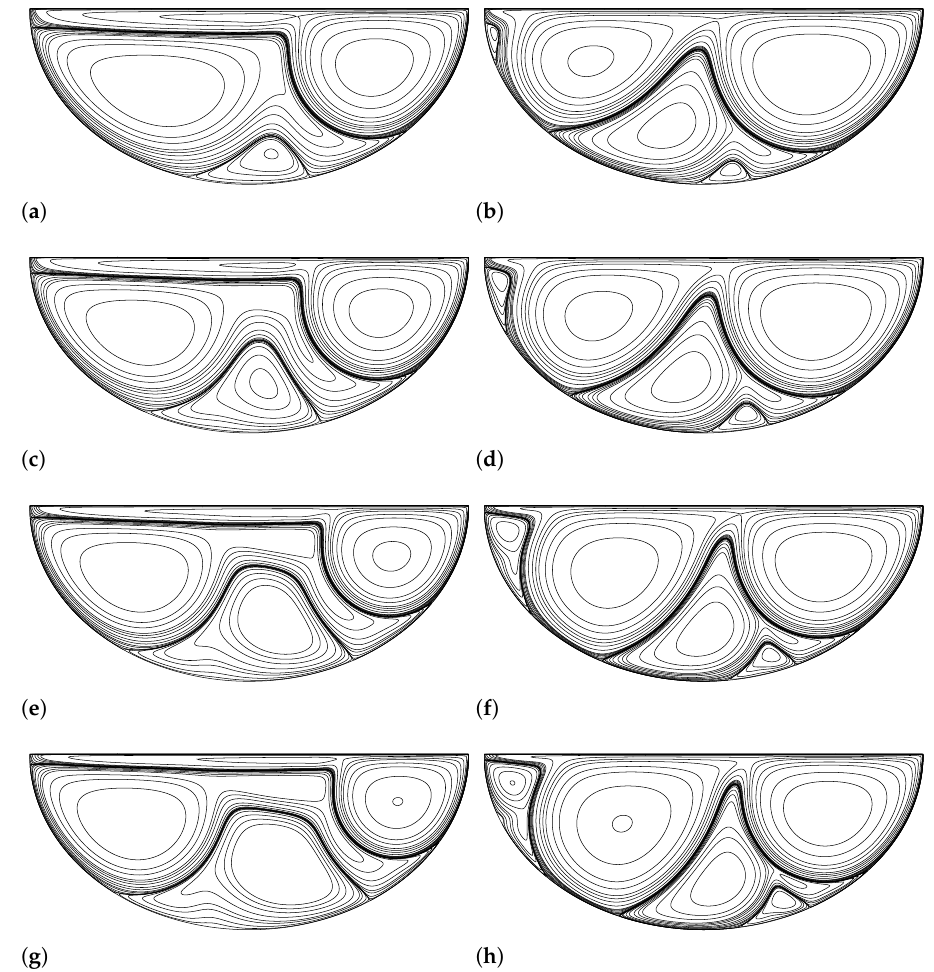
Figure 15. The 1st and 2nd solutions of driven semi-elliptical cavity flow with D = 0.8 aspect ratio at various same Reynolds numbers. ( a ) Re = 8000 (1st solution). ( b ) Re = 8000 (2nd solu- tion). ( c ) Re = 10,000 (1st solution). ( d ) Re = 10,000 (2nd solution). ( e ) Re = 15,000 (1st solution).